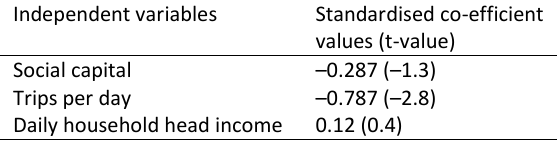
Table 6. Modelling risk of social exclusion and